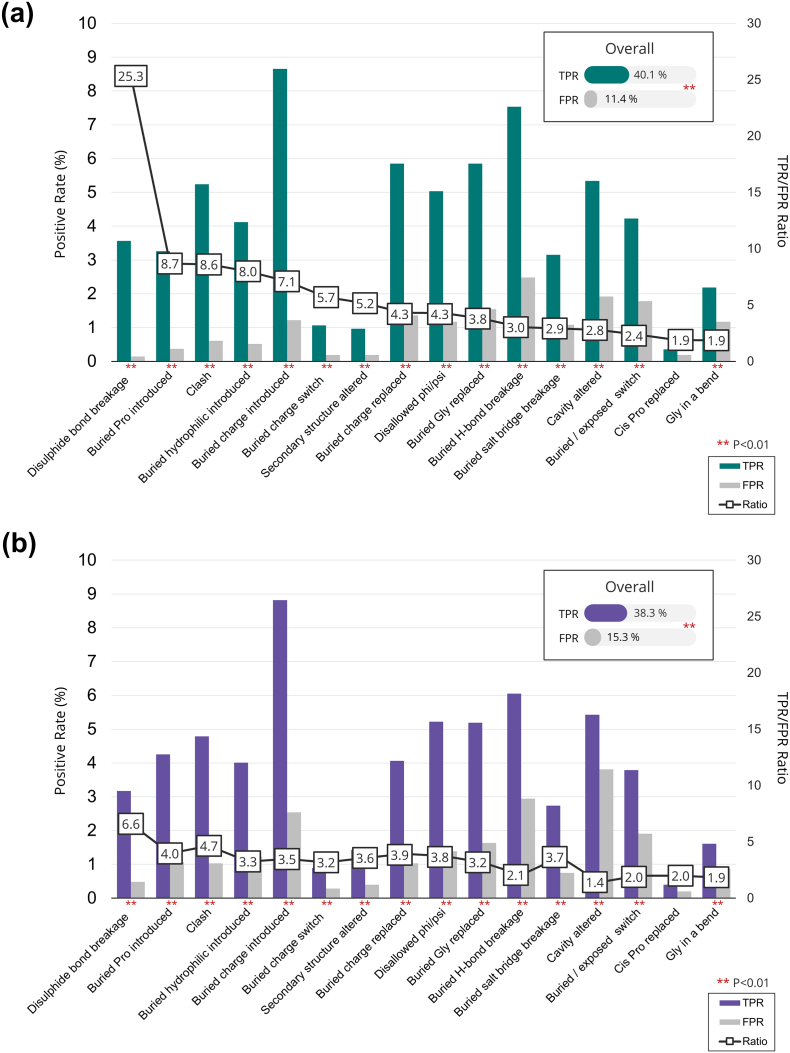
Performance of structural analysis on experimental structures. For each feature, the TPR on disease-associated (Disease) and the FPR on neutral (Neutral) variants are plotted as bars. The ratios of the true-positive to false-positive rates (TPR/FPR) are given, and for ease of viewing, these are connected by a line. The overall TPR and FPR on the entire data set are also reported. Significance at P < 0.01 (denoted by **) is evaluated in a one-tailed test of the difference of two proportions. Panel a are the results from the set of high-quality X-ray structures (resolution < 2.0 Å) from MolProbity's Top8000 database [37]. Panel b are the results on a second independent data set of 855 structures with lower resolution (< 2.5 Å) from the PDB.